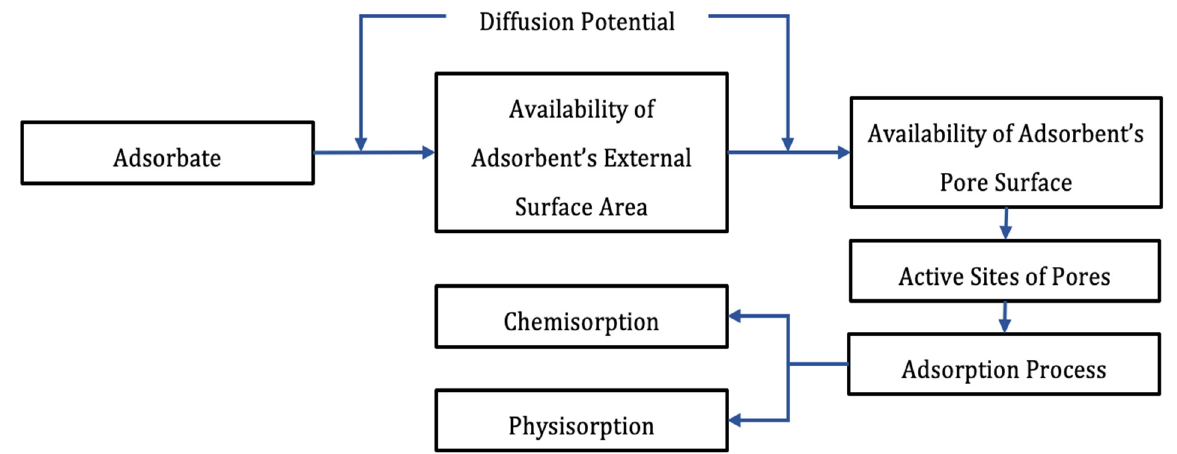
Figure 4. The adsorption pathway that leads to chemisorption or physisorption. Reproduced with permission from [34] (copyright reserved Elsevier, 2018).